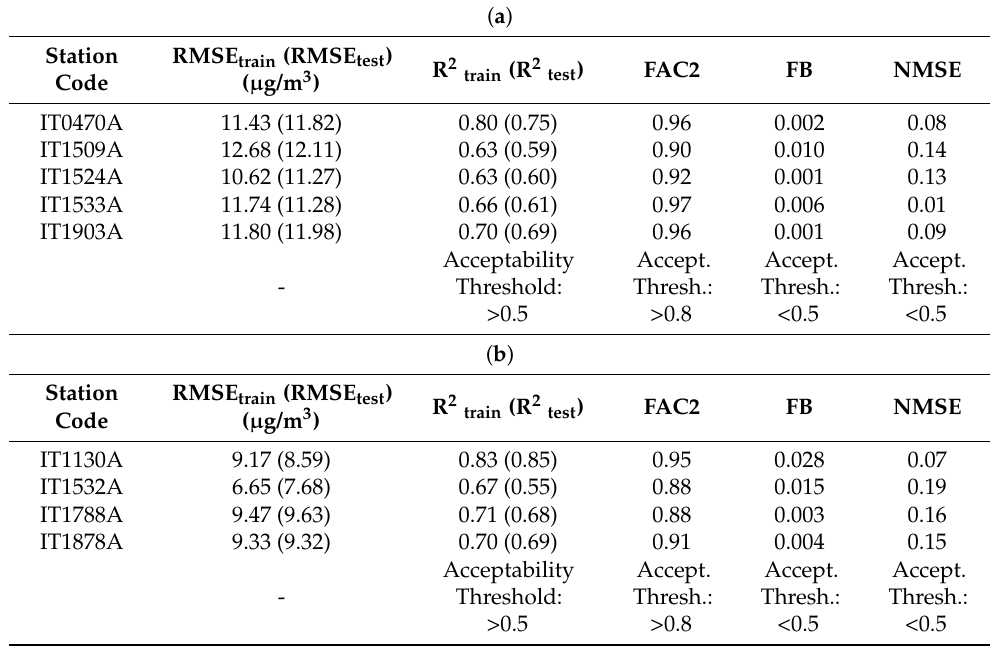
Table 3. ( a ) PM 10 model performance statistics. ( b ) PM 2.5 model performance